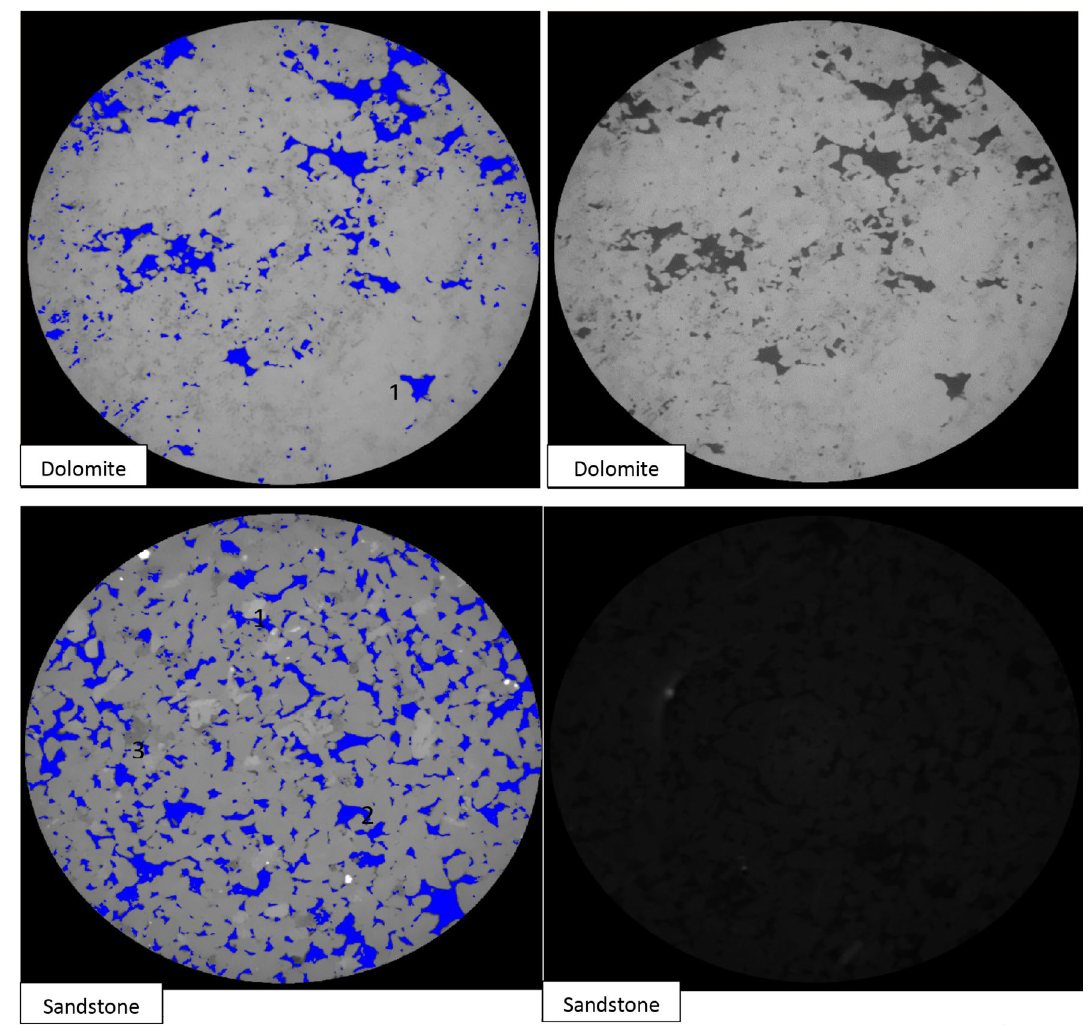
Fig. 10 Dolomite and sandstone formation: (left) segmented images; (right) raw